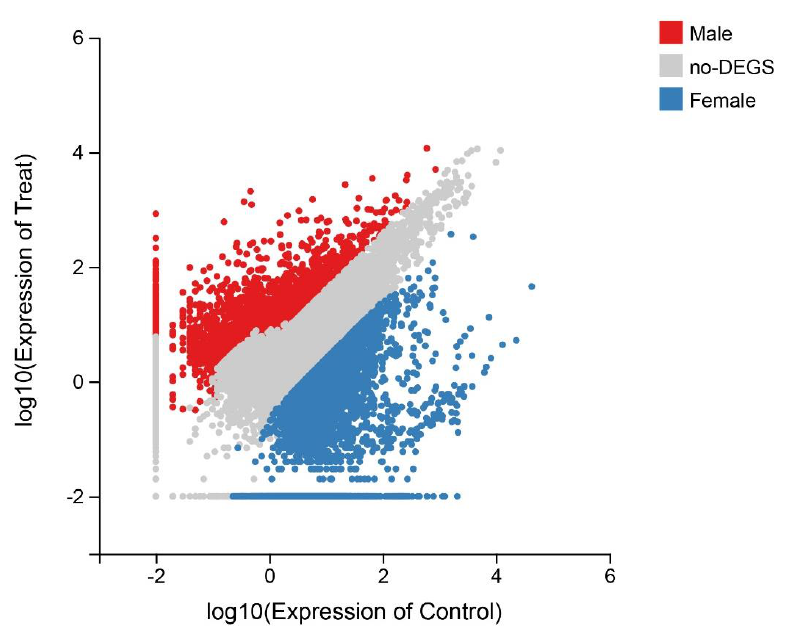
Figure 4. Scatter plots of Gene expression profiles in female and male S . elongata . Thresholds for inclusion were defined by p −value ≤ 0.01 and |log 2 fold change| ≥ 1. Table 2. Genes related to the sex differentiation of Saurida elongata